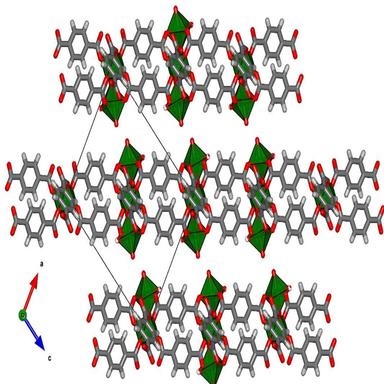
Structure of Ni3(C8H4O4)3(C3H7NO)4 along b axis, showing the 2D terephthalate network. Though present, the DMF molecules are deleted for clarity.